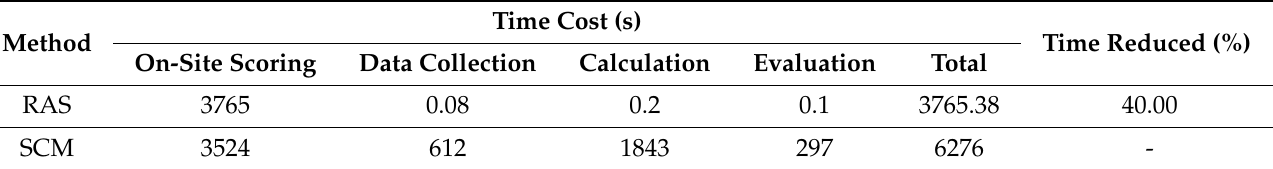
Table 7. Time cost of the risk assessment system and safety checklist